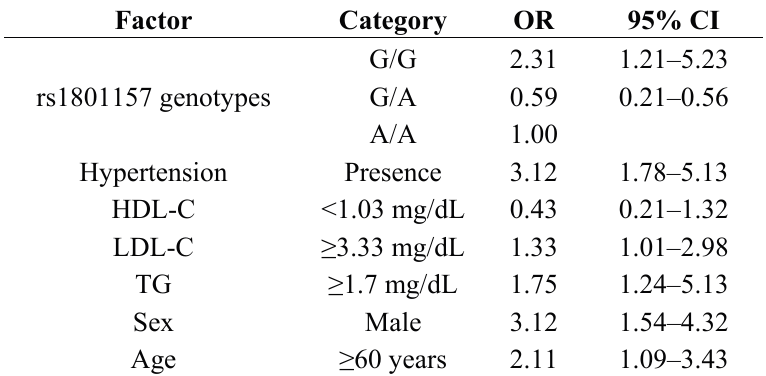
Table 3. Factors associated with the presence of coronary heart disease (CHD) in the multivariate